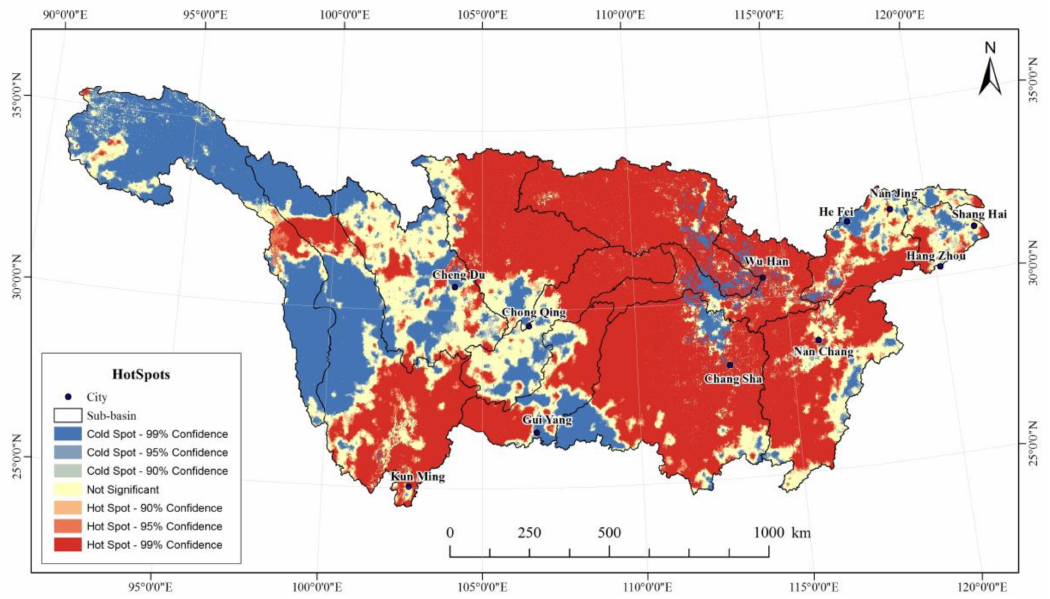
Figure 12. Spatial distribution of cold hot spots of human activity contribution in Yangtze River Basin. Table 8. Land use transfer matrix in the Yangtze River Basin from 2000 to 2018 (unit: km 2